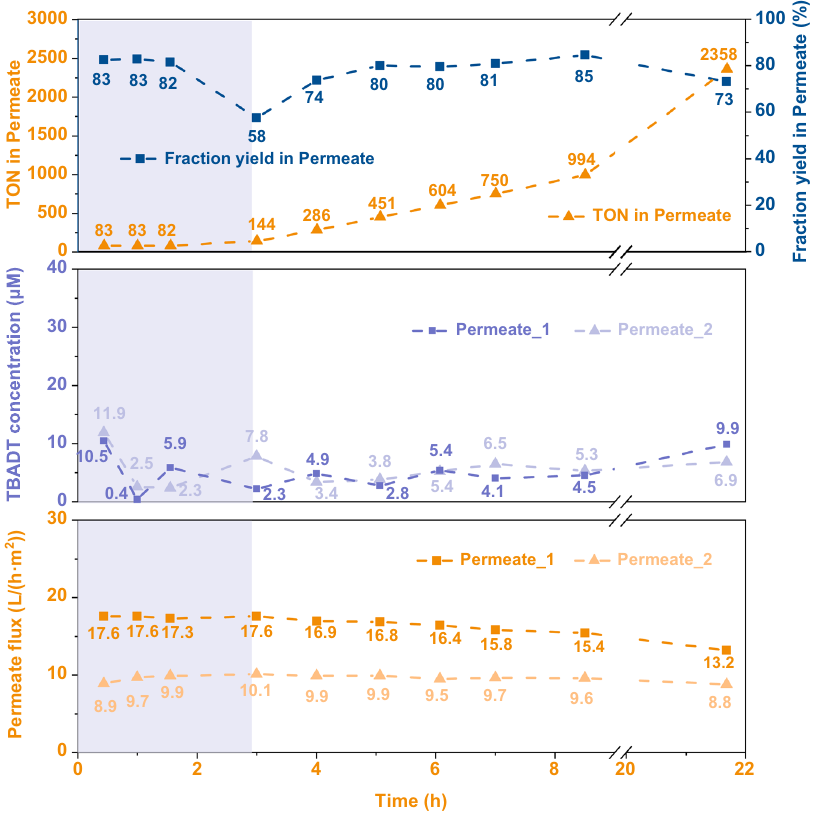
Fig. 4 | Results ofthe in-line catalyst recovery experiment. Data about turnover number and measured reaction yield, residual TBADT concentration in the